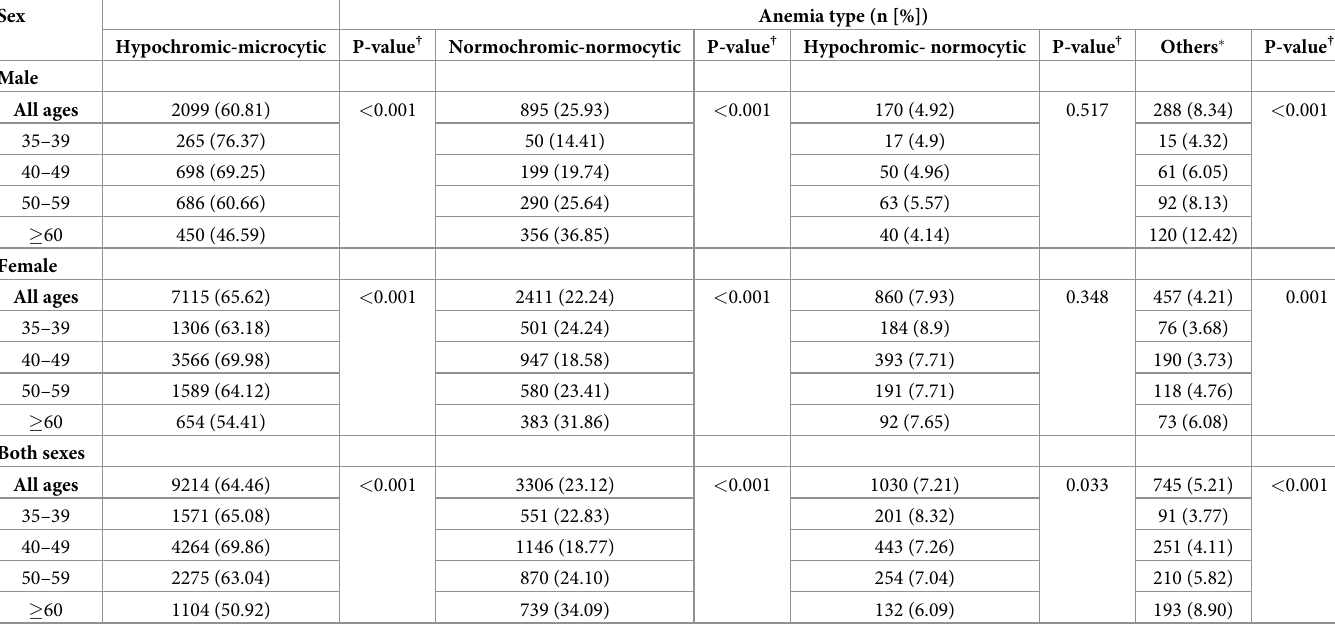
Table 4. Age-specific prevalence of different anemia types by sex (n = 14,295).